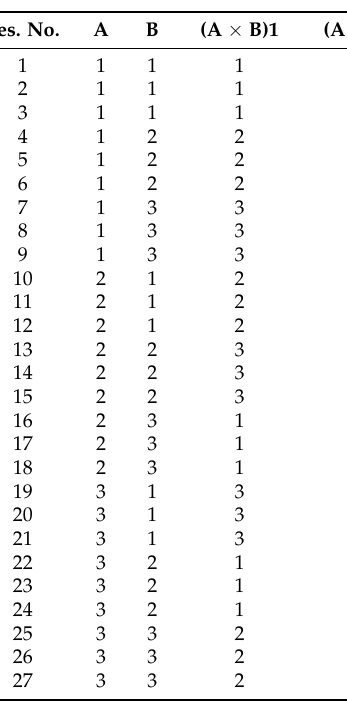
Table 4. Calculation of orthogonal